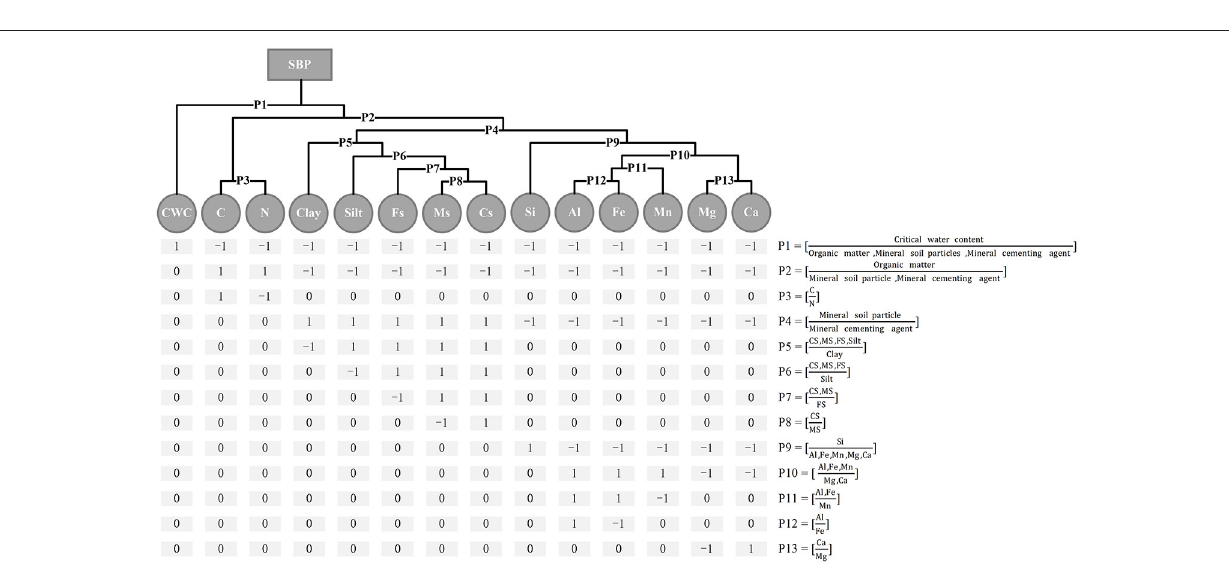
FIGURE 2 | Sequential binary partition (SBP) of soil components to compute isometric log ratios for maximum bulk density and critical water content. CWC, critical water content; Fs, fine sand; Ms, medium sand; Cs, coarse sand.